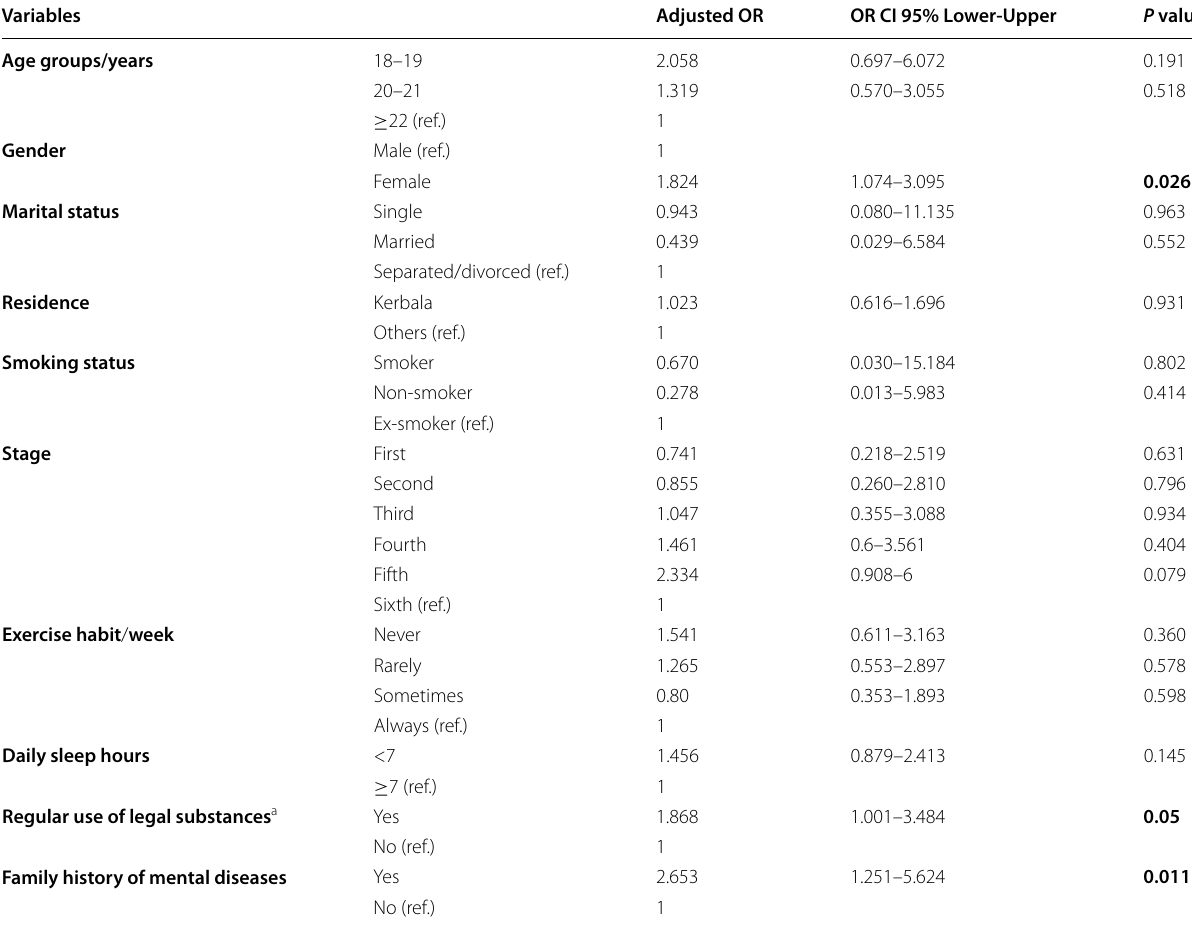
Table 3 Association between three-dimensional burnout diagnosis and socio-demographic characteristics of students from the College of Medicine, University of Kerbala ( N